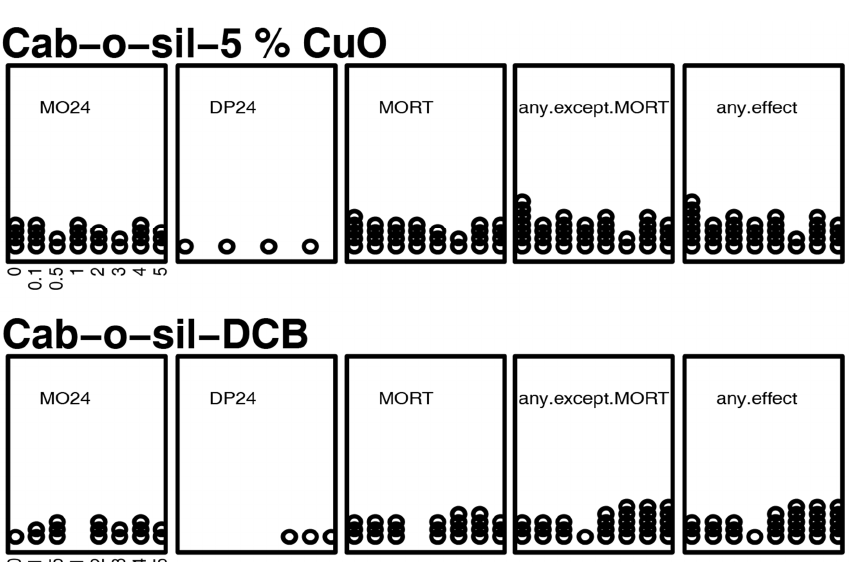
Figure 4. Incidence of overt toxicity responses to control DCB (at the concentrations of 0, 0.1, 0.5, 1, 2, 3, 4, and 5 µ g/mL in ultrapure water) at 24 and 120 hpf. of the figure depicts five endpoints—two at 24 h (MO24 = Mortality, DP24 = delayed development progression), and total mortality at five days (MORT). Two summary endpoints indicate individuals with any morbidity (any.except.MO), and any morbidity + mortality exhibited (any.effect). Each affected individual is illustrated as a